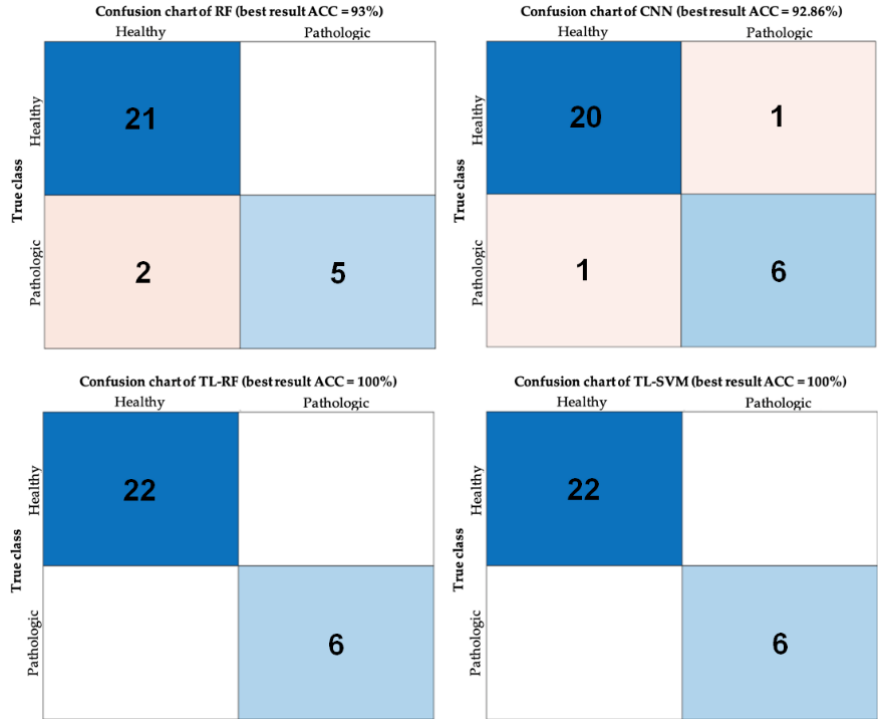
Figure 6. Confusion charts. Performance visualization using confusion matrix charts for the examined classification problem using the four different approaches (best accuracy out of the ten tests); accuracy (ACC). Table 3. Performance of the classification methods using different algorithms. All metrics are the average over 10 runs (**) Area under the curve (-) convolutional neural network (CNN) extracts its own features automatically from images.